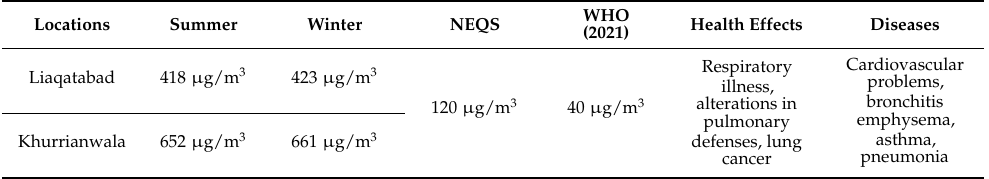
Table 1. Seasonal variation of SO 2 at selected sites in comparison to NEQS and WHO and corre- sponding health effects.